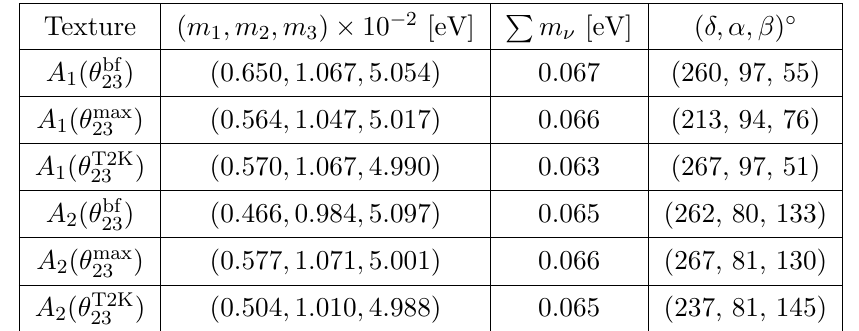
Table 7 . Simulated values for the textures A 1 ; A 2 for normal neutrino mass hierarchy. Two sets of solutions are presented for both the textures, which are calculated corresponding to the global best-(cid:12)t value of (cid:18) 23 i.e., (cid:18) bf = 47 : 7 (cid:14) [4], for the maximal value of (cid:18) 23 i.e., (cid:18) max 23 latest T2K [114] results,